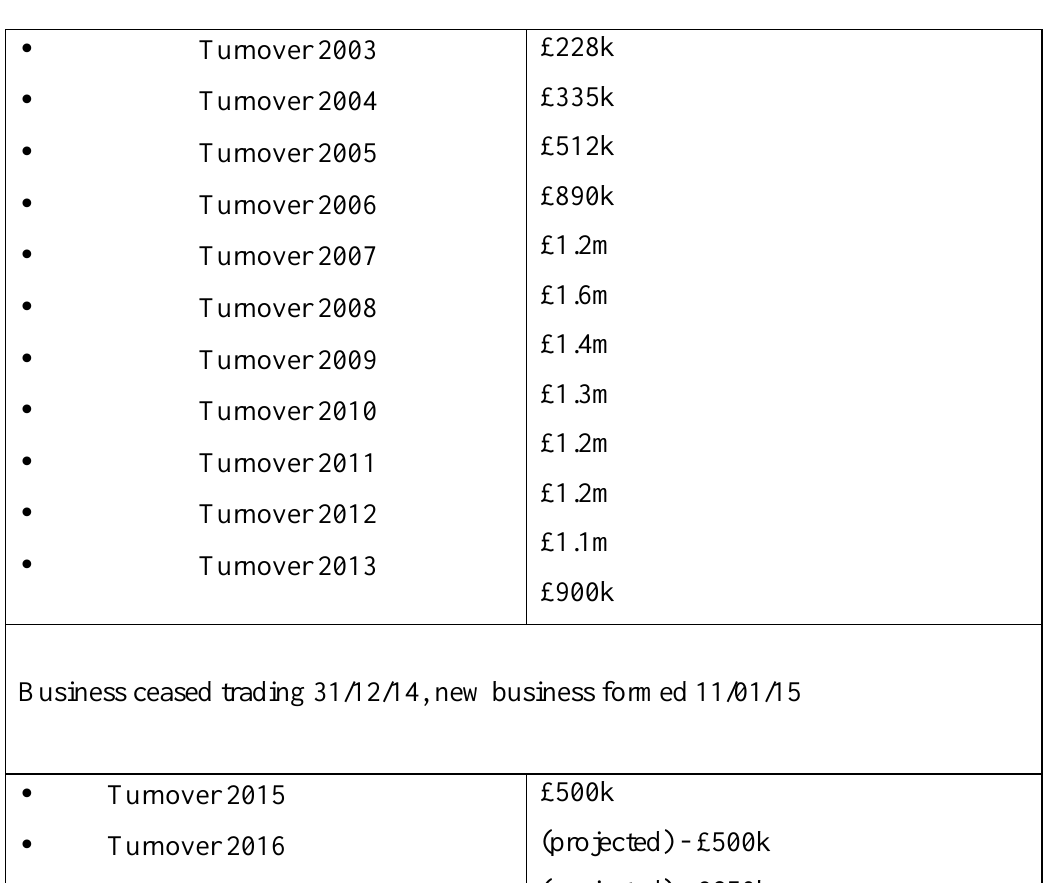
Table 1: Paul’s Quality Butchers Ltd Financial